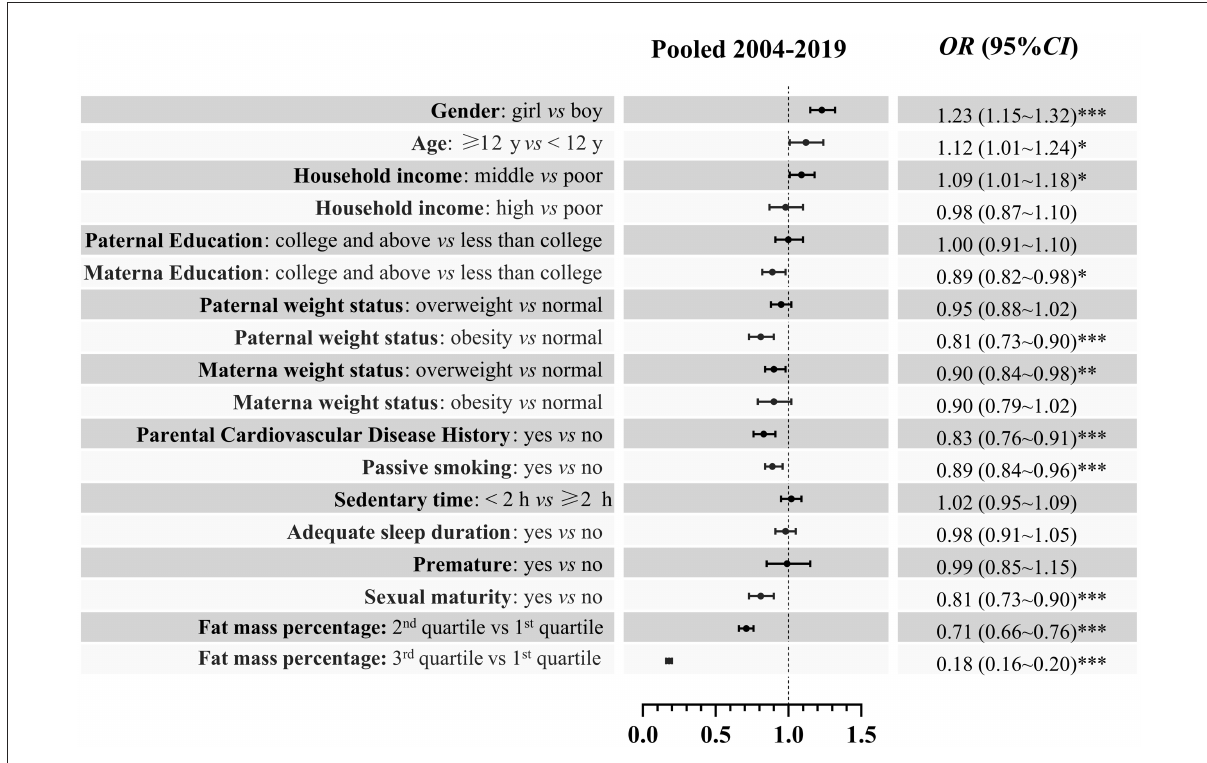
FIGURE6 Sensitivity analyses with complete case: Association [OR (95%CI)] between demographic factors and ideal cardiovascular health among children and adolescents in Beijing. *0.01 ≤ P < 0.05; **0.001 ≤ P < 0.01; *** P <